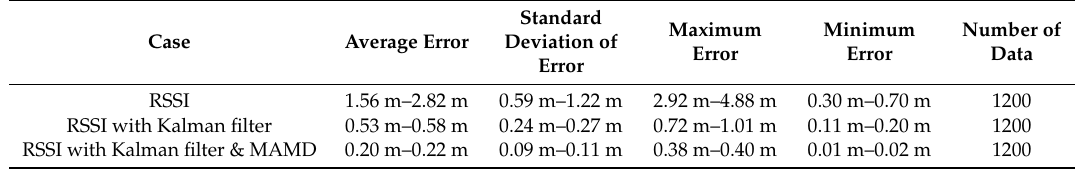
Figure 7. Detection of location for fixed tag in underground construction site. Table 2. Results of error range for fixed tag.